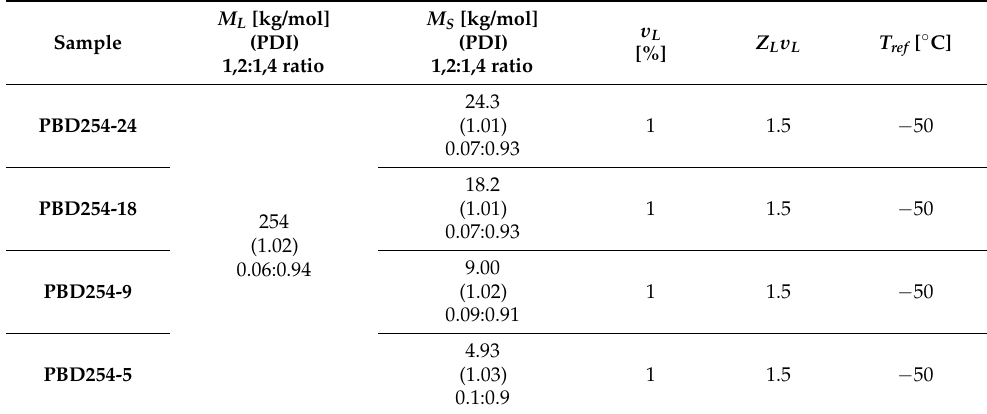
Table 2. Molecular characteristics of PBD